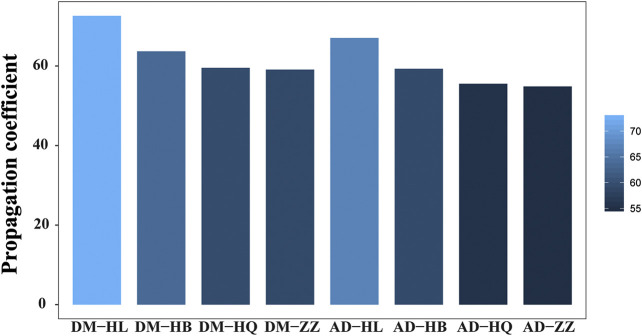
The propagation coefficient of HJD botanical drugs in diabetes mellitus (DM) and alzheimer’s disease (AD).